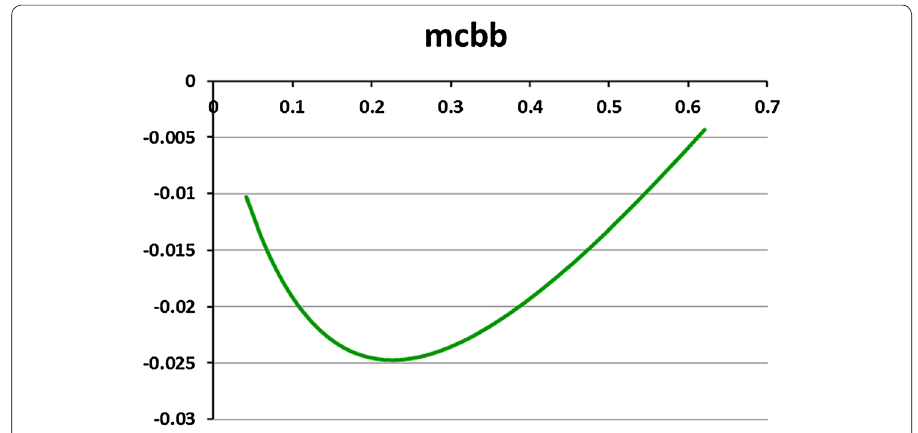
Fig. 11 Dynamic BBR